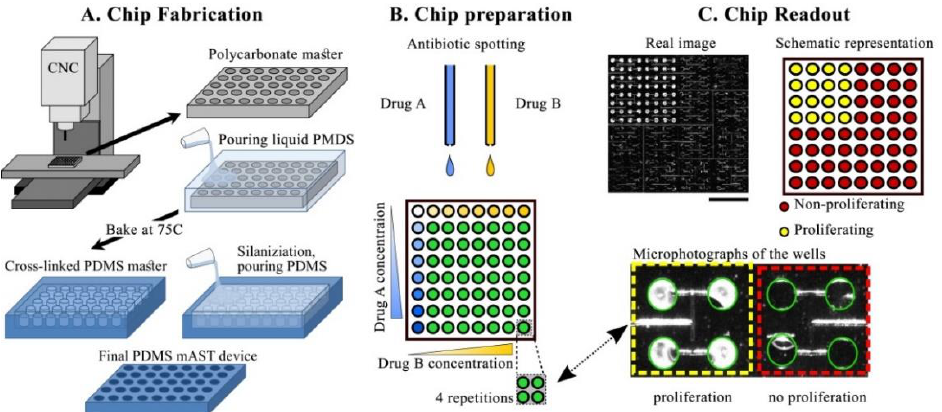
Figure 2. Preparation and readout of a high-content microwell antibiotic susceptibility test (AST) (mAST). ( A ) Fabrication of the mAST device. ( B ) Preparation of the chip by spotting gradients of antibiotics, in 4 repetitions each. ( C ) Readout of the mAST after incubation. C Top Left : image of the mAST with brighter microwells (proliferating bacteria) and darker (unchanged) wells. Scale bar is 1 cm. C Top Right : binary representation in which wells the bacteria proliferated. C Bottom : microphotograph of part of the mAST with 4 wells with proliferating bacteria (in the left, bright) and 4 wells without bacteria proliferation (in the right, dark). Well contours are outlined in green to guide the eye. The small areas of different color within microwells are trapped gas bubbles of different refractive indexes than the culture medium. Width of the well is 1 mm, which can serve as scale bar.